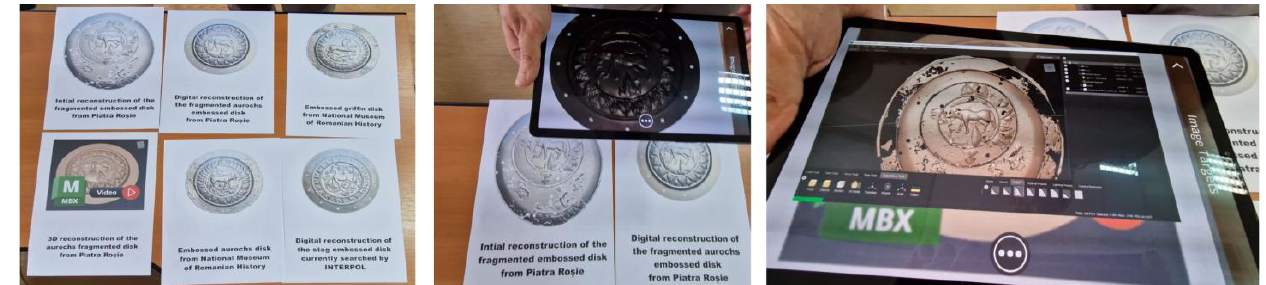
Figure 26. Overview of the augmented reality developed in Unity using Vuforia Engine.